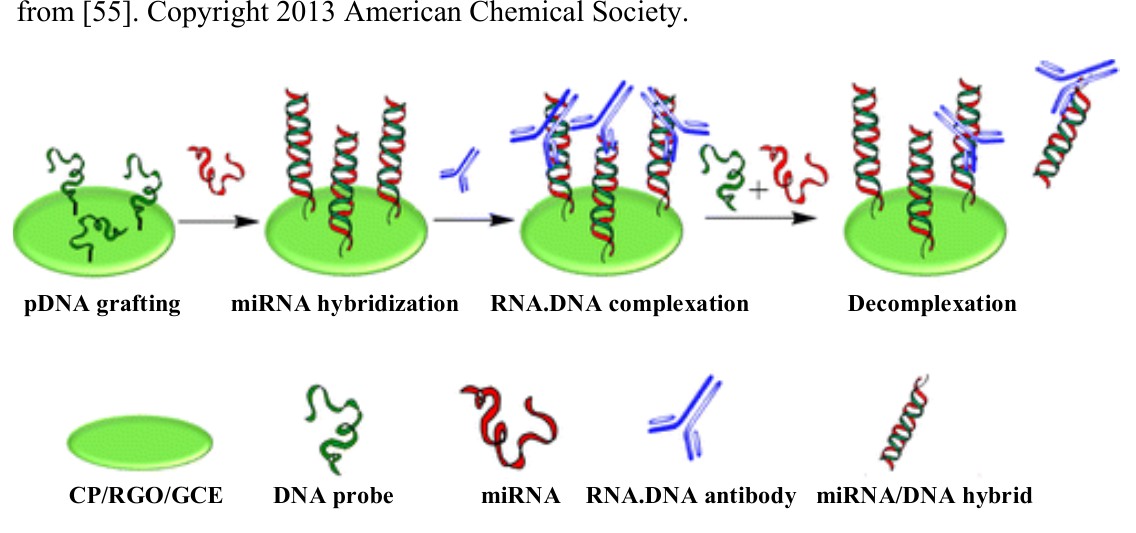
pDNA grafting miRNA hybridization RNA.DNA complexation Decomplexation